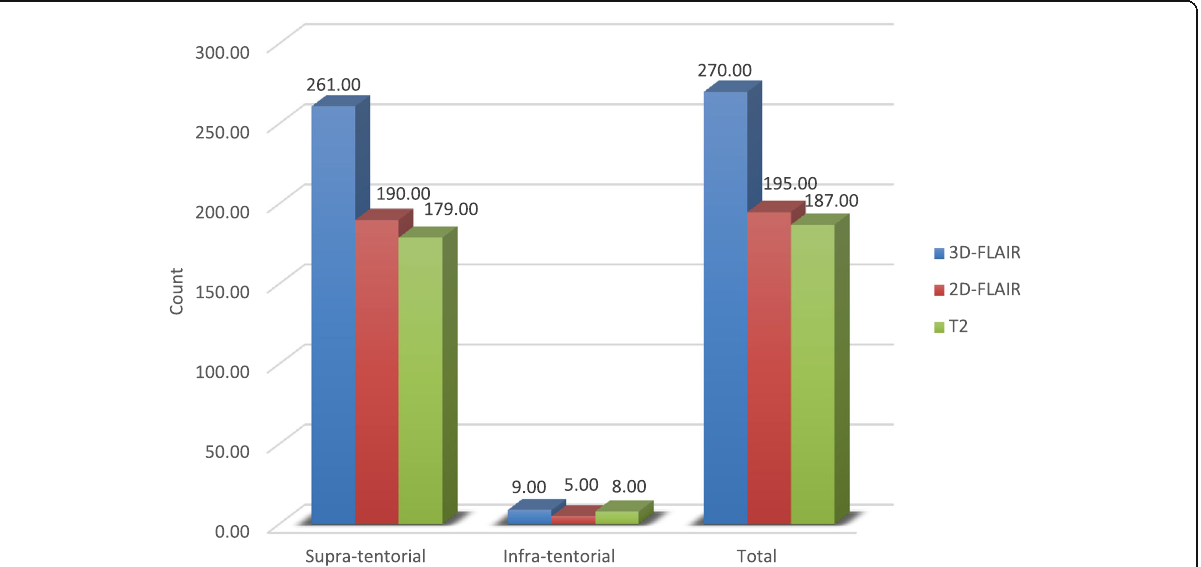
Fig. 2 Analysis of the lesion load detection by 3D-FLAIR, 2D-FLAIR, and T2WI according to the total number of lesions in the supratentorial, infratentorial regions and in both